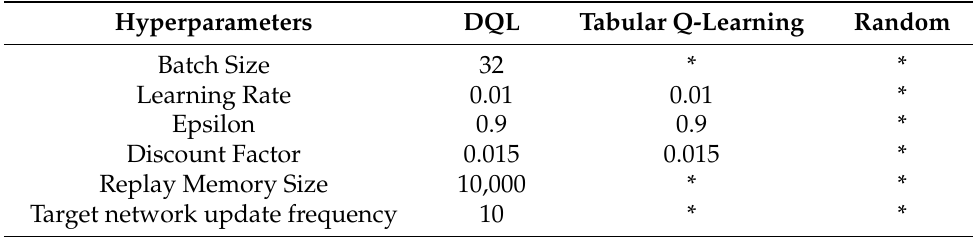
Table 2. Fixed hyperparameters of the three